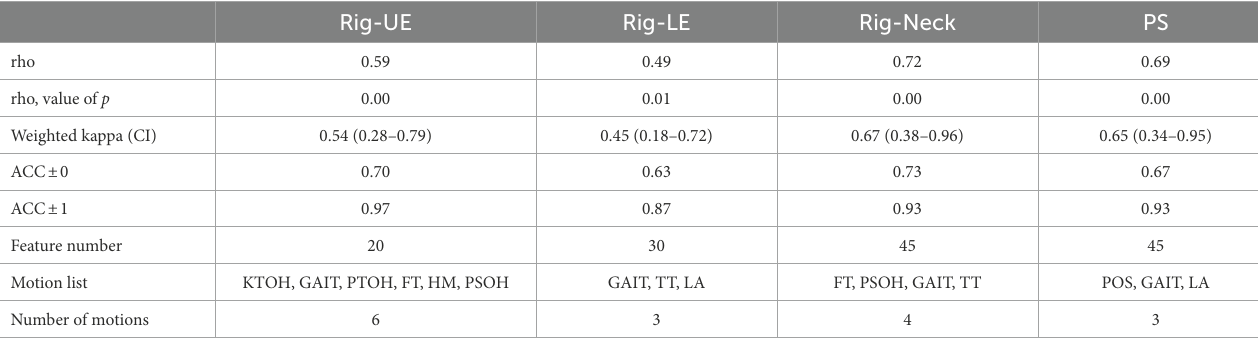
TABLE 3 The performance of four models after item